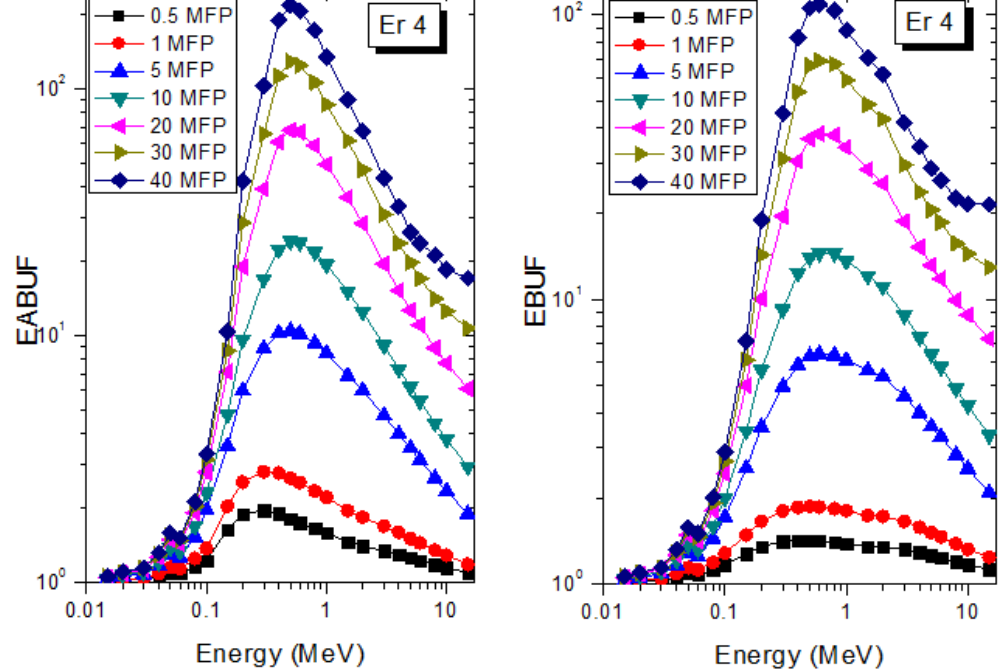
Figure 4. EABUF and EBUF variation with gamma-ray photon energy for Er 4.